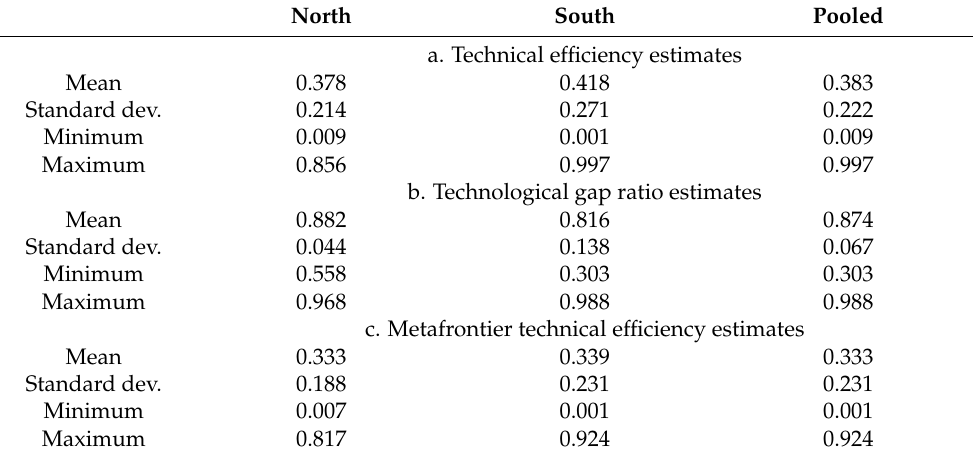
Table 4. Summary statistics for the technological gap ratio (TGR) and the technical efficiencies obtained from the region-specific stochastic frontiers and the metafrontier production